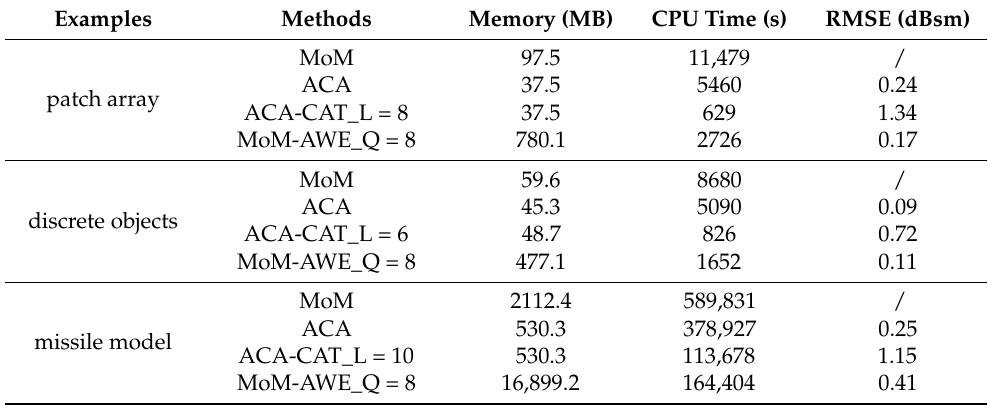
Table 2. CPU time, memory requirements and RMSE of four different methods for wideband RCS simulation of three